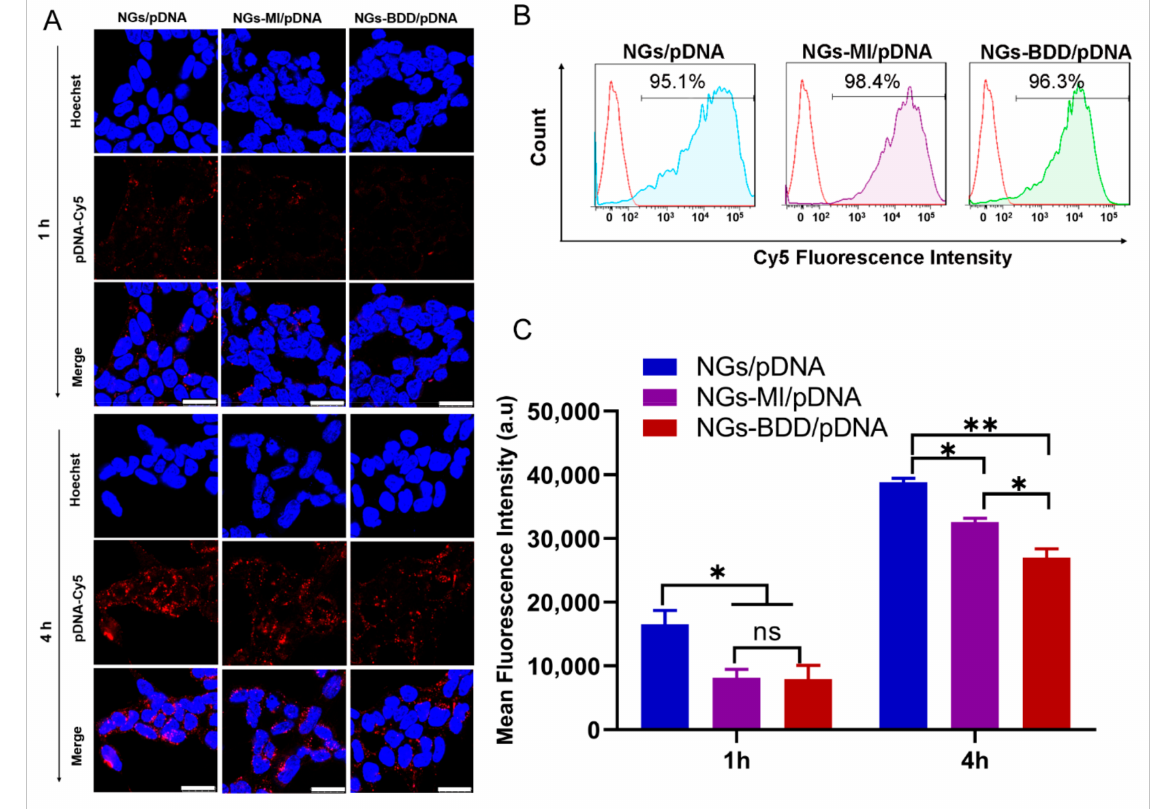
Figure 4. Cellular uptake of nanogel/pDNA complexes in HEK293T cells. ( A ) CLSM images of cells after incubation with NGs/pDNA, NGs-MI/pDNA, and NGs-BDD/pDNA complexes for 1 h and 4 h. pDNA and nuclei were labeled with Cy5 and Hoechst 33342, respectively. Scale bars are 25 µ m. ( B ) Flow cytometry histograms of cells incubated with nanogel/pDNA-Cy5 complexes for 4 h. ( C ) Mean fluorescence intensities of cells incubated with nanogel/pDNA-Cy5 complexes at indicated time points. Data presented mean ± SD from three independent experiments performed in duplicate (* p < 0.05, ** p < 0.005).